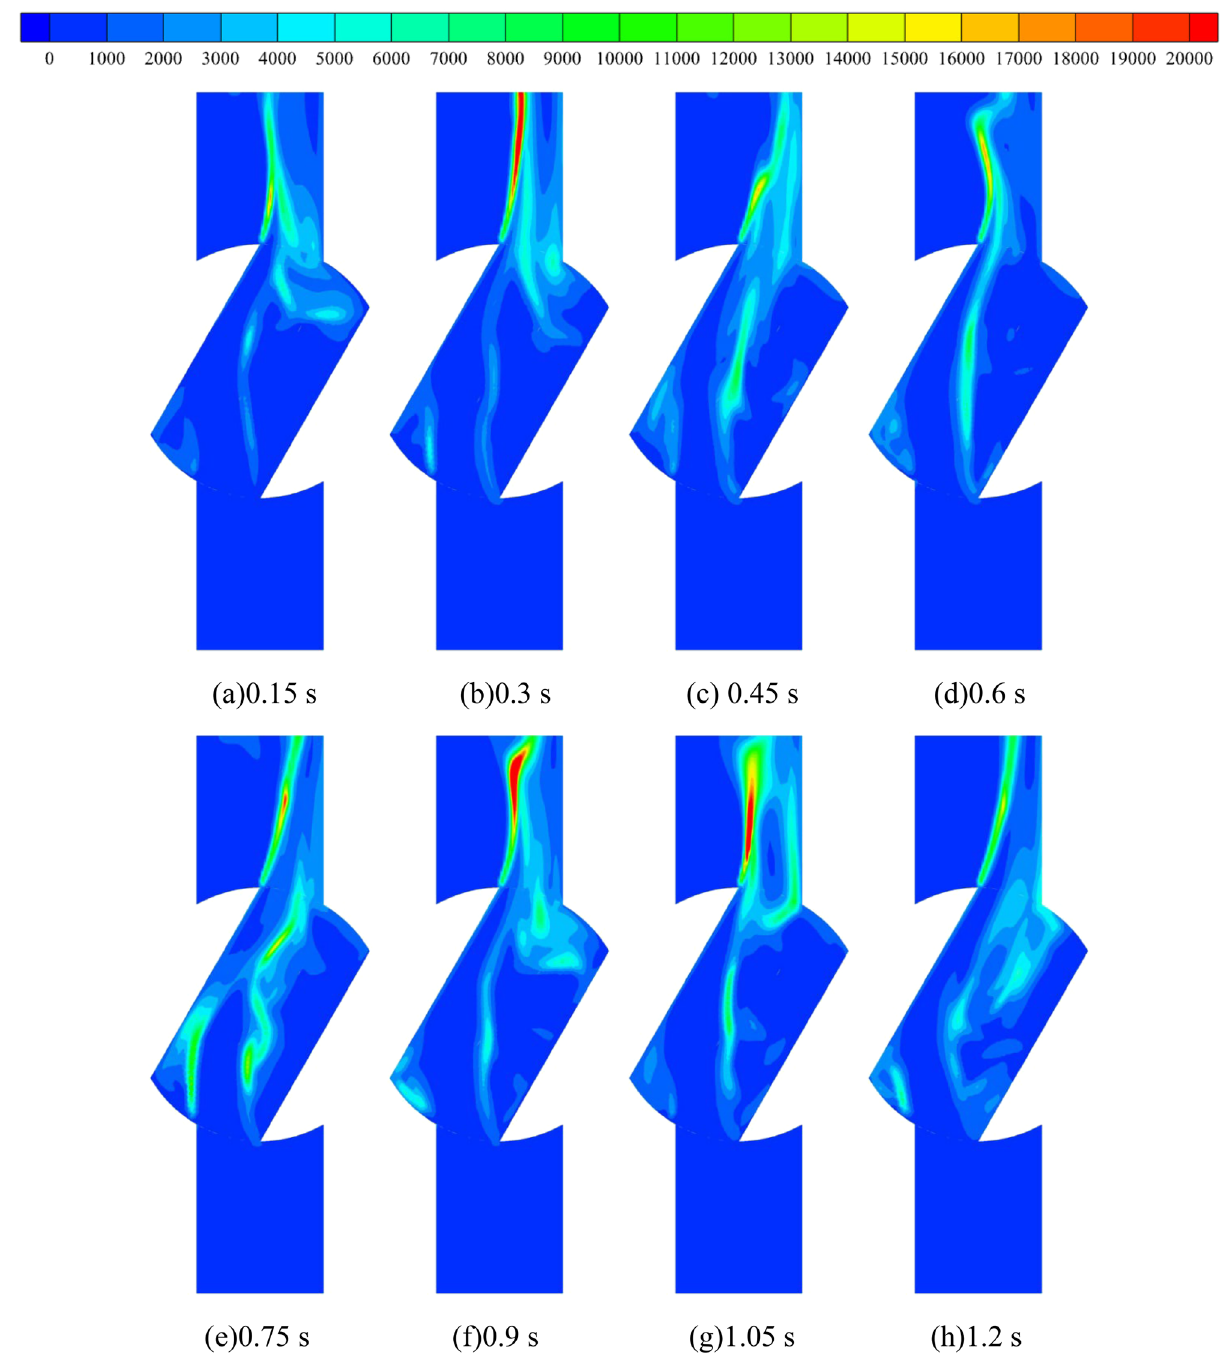
Figure 25. Entropy production distribution in the valve domain during medium-speed start-up (W/(m 3